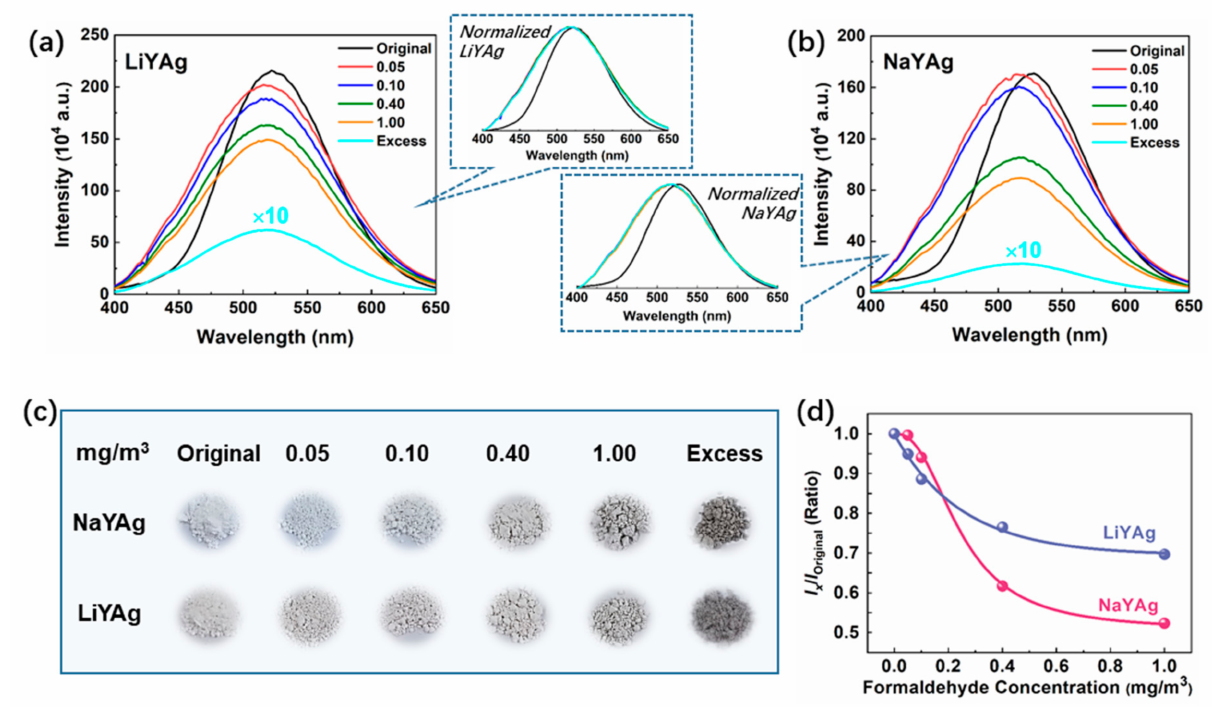
Figure 4. PL spectra of LiYAg ( a ) and NaYAg ( b ) before and after exposing to different contents of formaldehyde atmospheres; digital photographs of LiYAg and NaYAg after exposing to different contents of formaldehyde atmospheres under natural light ( c ); relative emission intensity of LiYAg and NaYAg at increasing contents of formaldehyde gases ( d